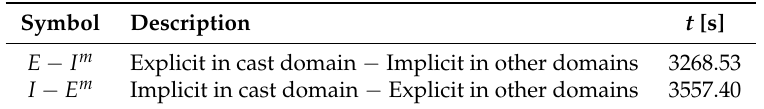
Table 5. A total time t of computations obtained for the partitioning methods ( m = 1). The different integration methods and the same time step.